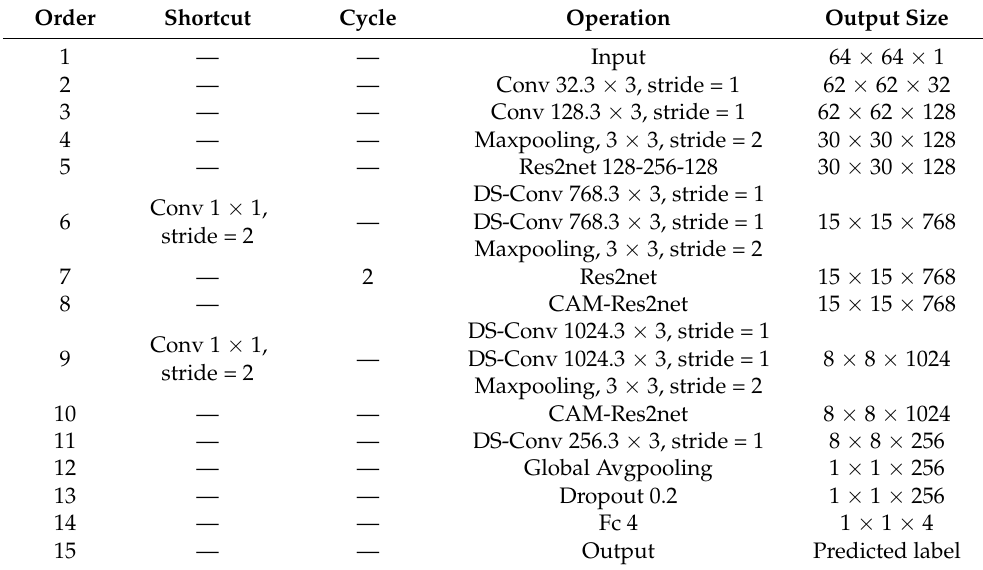
Table 1. The configuration of the proposed multi-scale CNN for BTs